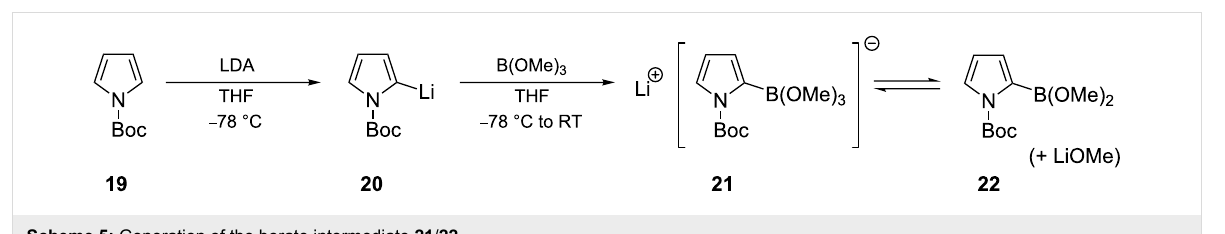
Scheme 5: Generation of the borate intermediate 21 / 22